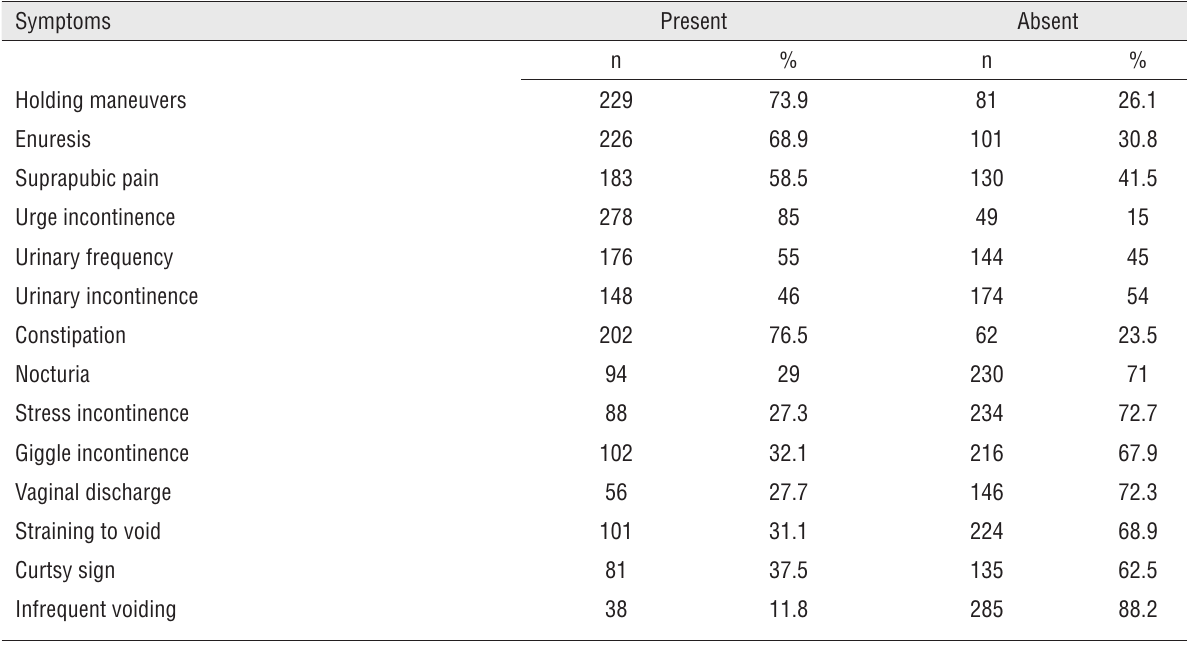
Table 1 - Distribution of lower urinary tract symptoms in the sample population.